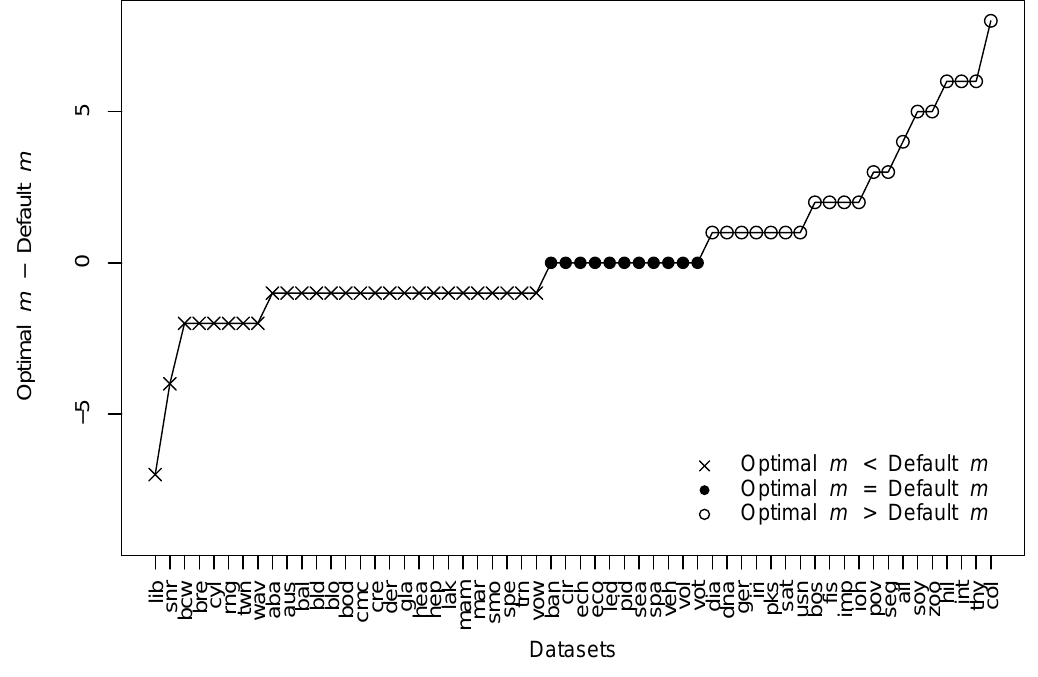
Figure 2. The difference between the optimal size and the default size.